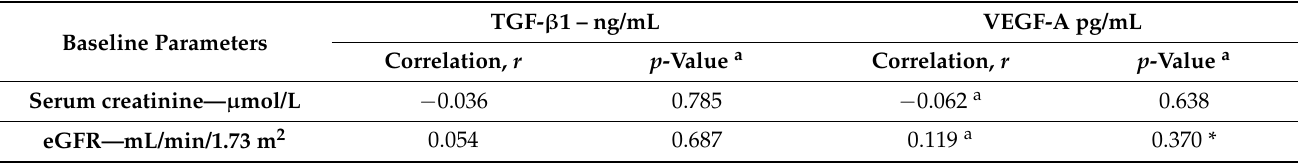
Table 4. Correlation between renal parameters with TGF- β 1 and VEGF-A.